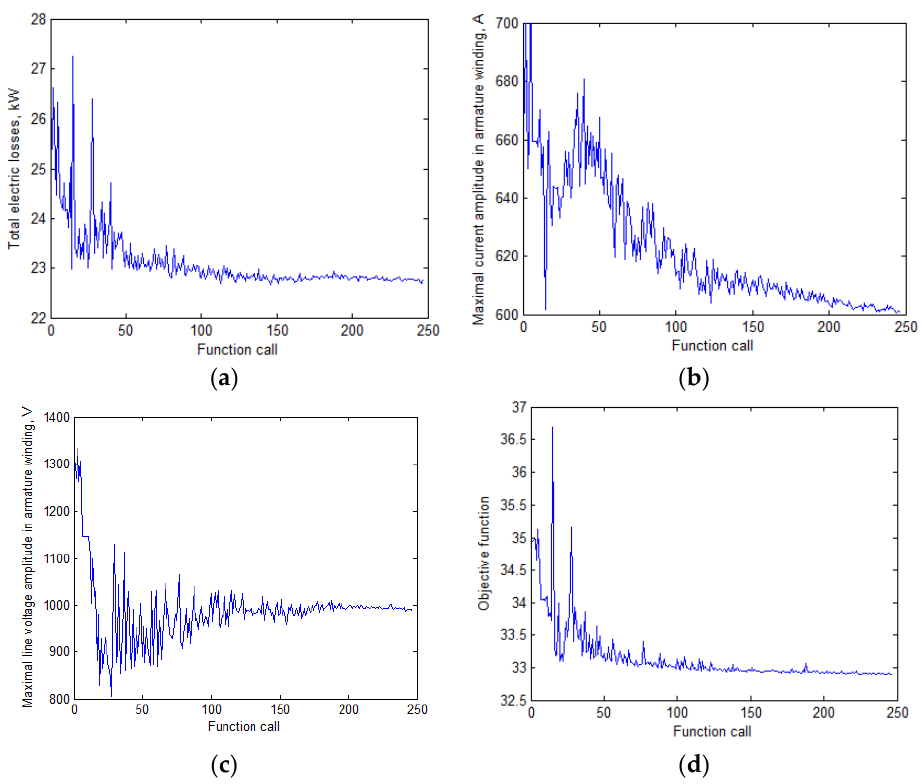
Figure 5. Variations in the objectives during the optimization: ( a ) total losses < P losses >; ( b ) maximum current amplitude in the armature winding; ( c ) maximum voltage amplitude in the armature winding; ( d ) objective function F .